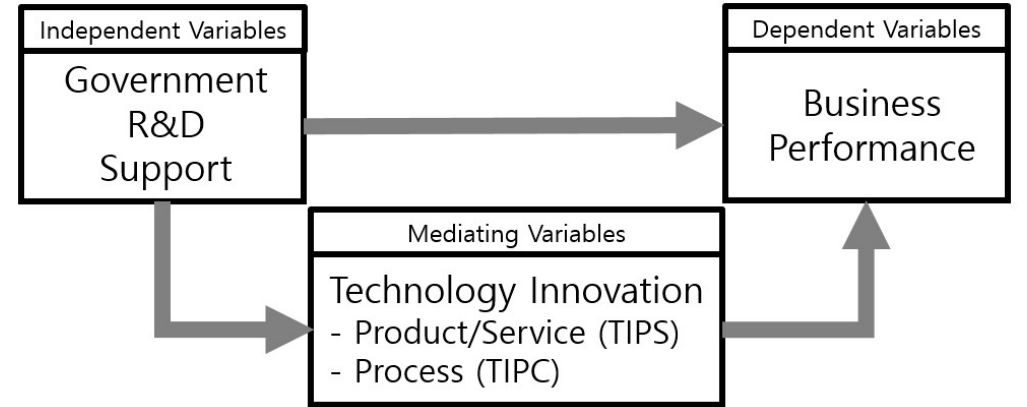
Figure 2. Research Model. Note: Mediating effects of Technology innovation on product and service (TIPS) and process (TIPC).